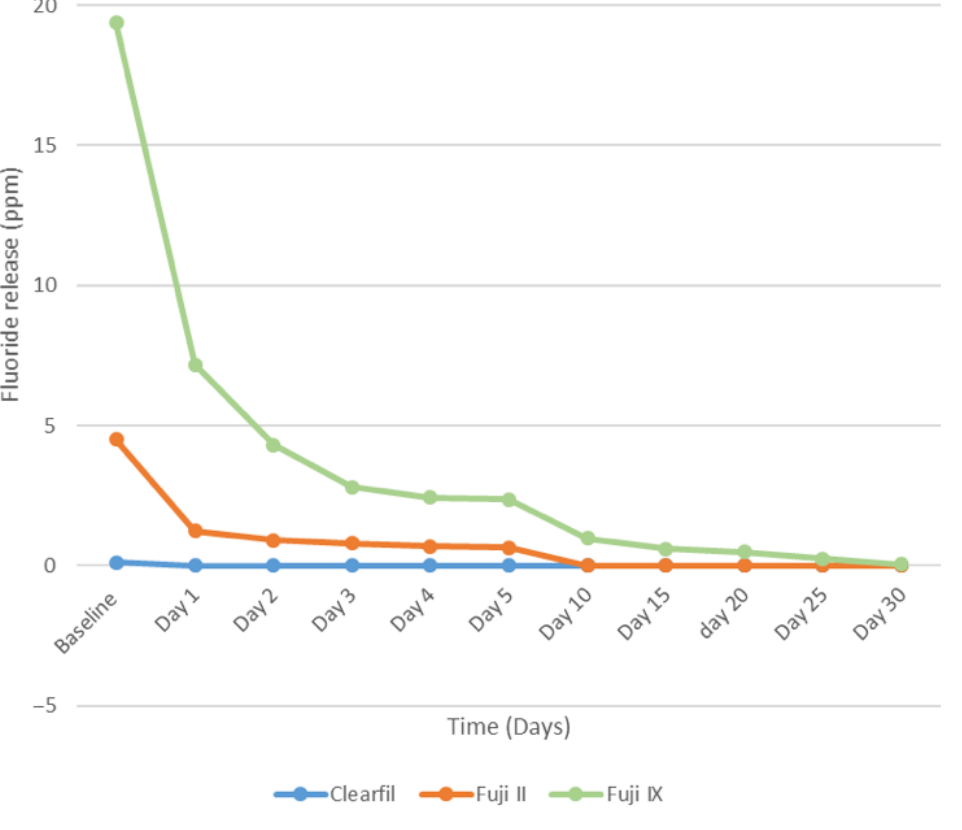
Figure 2. Comparison of Fluoride released from the three materials at each time point for 30 days. The data presented in Figure 3 indicates a significant correlation between the type of material and the cumulative fluoride concentration in the medium. The ranking of materials in terms of fluoride release is as follows: Fuji IX > Fuji II > Clearfil UBQ. Glass ionomer cements demonstrated prolonged fluoride release over the duration of the study. Among the glass ionomer cements examined, the resin-modified GIC (Fuji II LC) exhibited a lower rate of fluoride release in comparison to the conventional GIC (Fuji